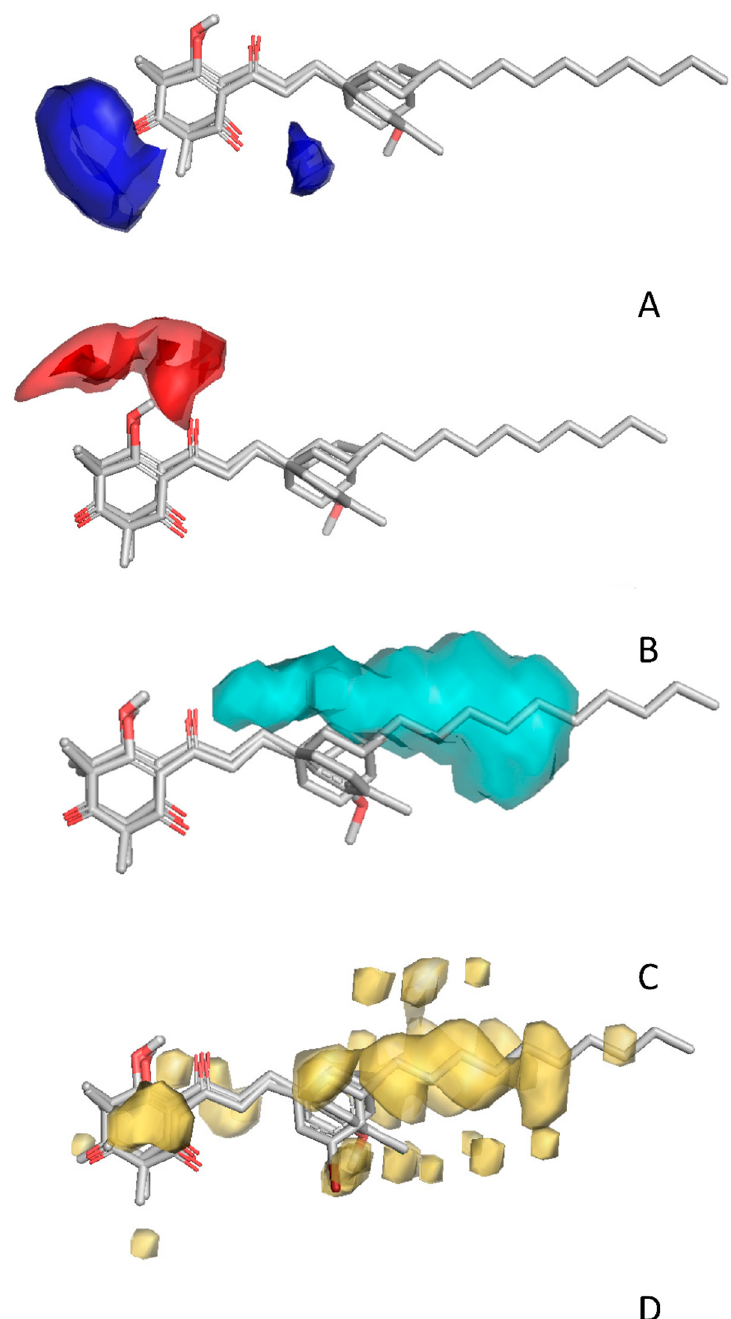
Figure 3. Structural features contributing positively to the activity of 2-acyl-cyclohexane-1,3-diones on HPPD. ( A ) Blue fields highlight hydrogen donor regions that promote activity. ( B ) Red fields highlight hydrogen acceptor regions that enhance activity. ( C ) Cyan fields identify the regions where increase in steric bulk increases activity. ( D ) Yellow fields delineate regions where hydrophobic interaction contributes to activity.